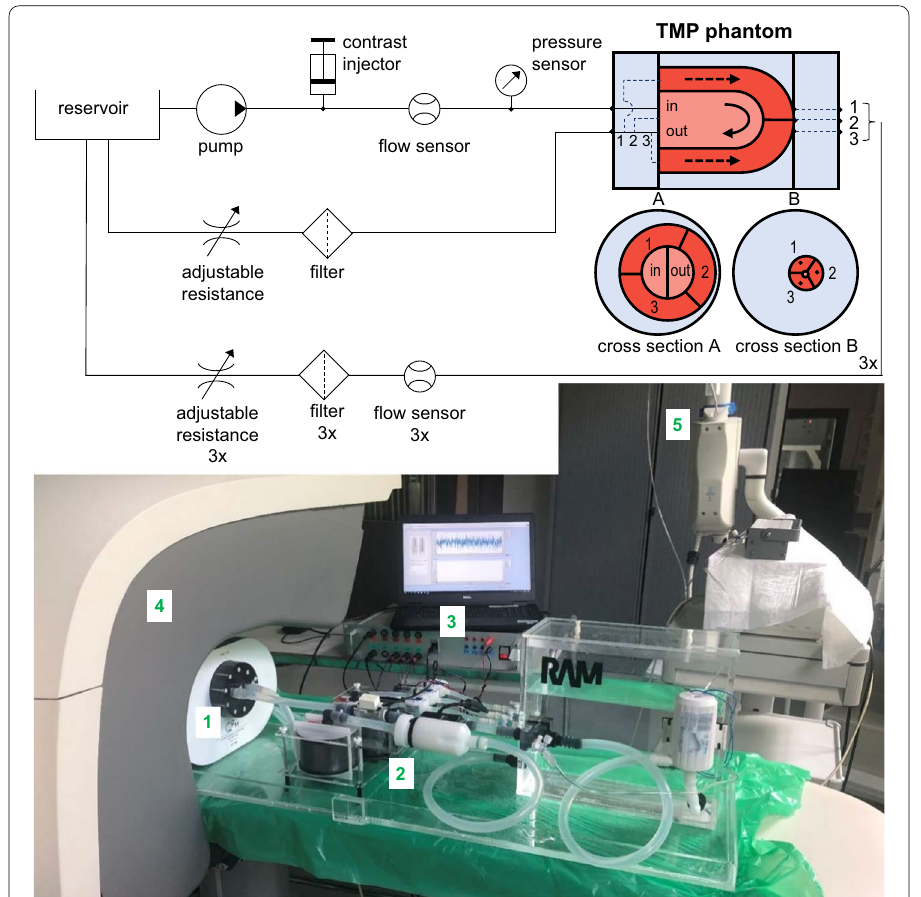
Fig. 3 Fluid circuit diagram of the Twente Myocardial Perfusion (TMP) phantom setup (top) and subsequent experimental setup during performance testing (bottom). The numbers represent the following components: 1. the myocardial perfusion (and thorax) phantom, 2. its accompanying fluid circuit, 3. in-house built hard- and software for pump steering and sensor readout, 4. dynamic SPECT scanner and 5. the contrast